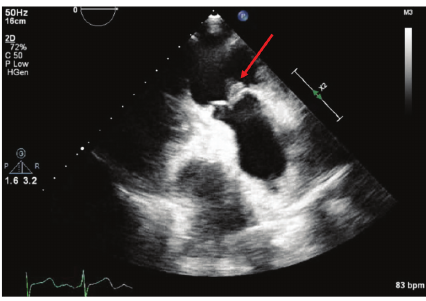
Figure 1: Transthoracic echocardiogram showing a 10mm × 11mm vegetation (arrow) on the ventricular aspect of the pulmonic